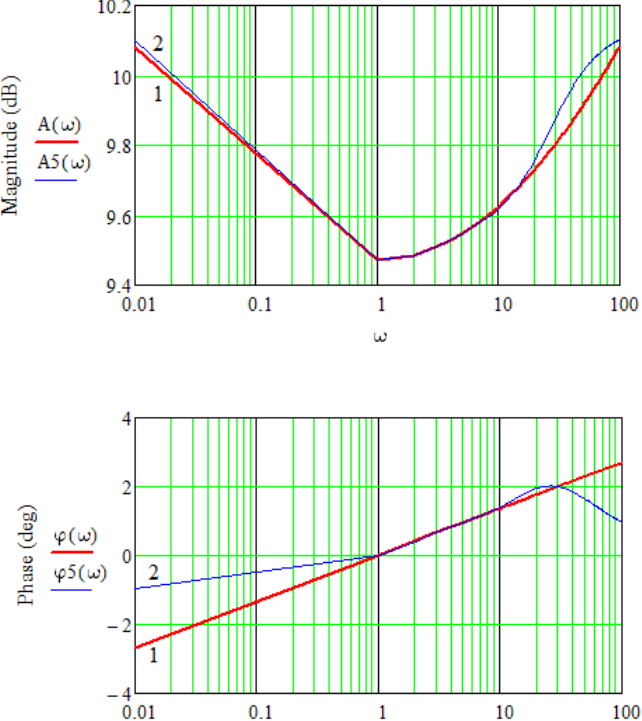
Figure 7. Reference frequency characteristics 1 and frequency characteristics for the fifth approxi- mation order if α = ±0.1; 2 for n = 5.